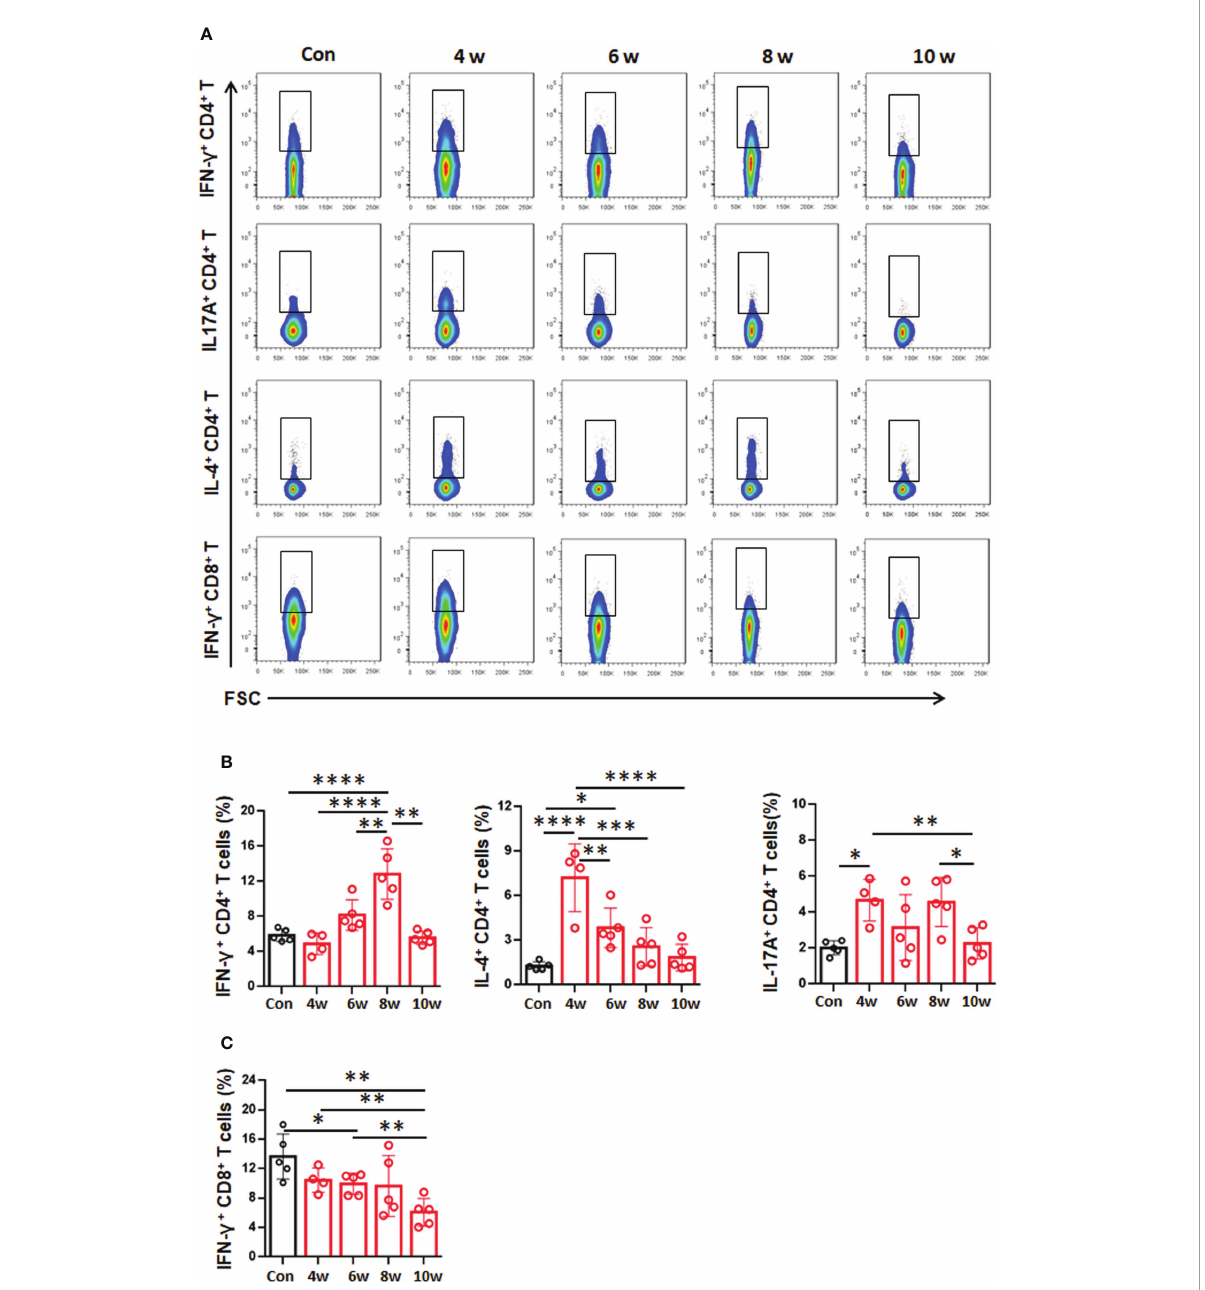
FIGURE 5 Distribution of T-cell subsets in the liver in the mouse model during Egranulosus s.s. establishment. (A) Representative fl ow cytometric analysis for IFN- g , IL-17A and IL-4 production in CD4 + T-cell subsets or IFN- g production in CD8 + T-cell subsets in the liver from mouse model during Egranulosus s.s. establishment. (B) The percentage of IFN- g , IL-17A and IL-4 production in CD4 + T-cell subsets in the liver, from (A) . (C) The percentage of IFN- g production in CD8 + T-cell subsets in the liver, from (A) . 4-5 mice per group. Data are expressed as mean ± SD, analyzed by one way ANOVA. * P < 0.05, ** P < 0.01, *** P < 0.001, **** P < 0.0001, no signi fi cance(n.s.) P >